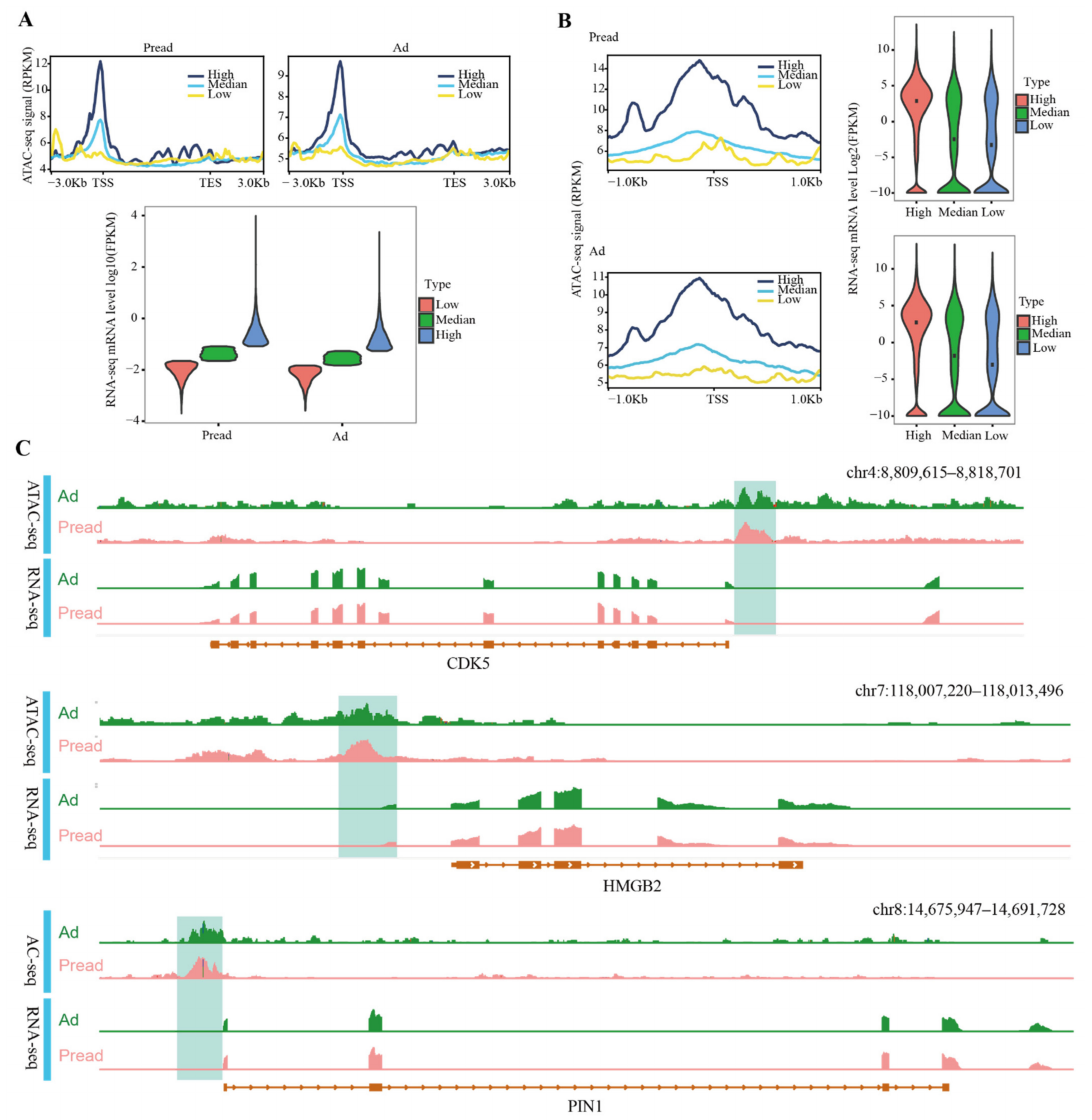
Figure 4. Association between ATAC signal and gene expression in Pread and Ad groups. ( A ) Association between ATAC signal within gene bodies and its 3kb upstream and downstream and gene expression. All genes were separated into three groups (high, medium, low) by expression level. Profile plots (above) display the difference in ATAC signal of each group. The horizontal axis represents different gene positions, and the vertical axis represents ATAC-seq signal intensity. Violin plot (below) show mRNA levels of high, medium and low groups divided by the gene activity value (RPKM). Plot width represents the density of repeated values in the range. ( B ) Association between ATAC signal within 1kb upstream and downstream of the TSS and gene expression. The same method is used to divide the high, medium and low groups according to RPKM and gene expression levels (FPKM). ( C ) The enrichment of ATAC-seq and RNA-seq signal near CDK5, HMGB2 and PIN1. Direction of the transcription is represented by an